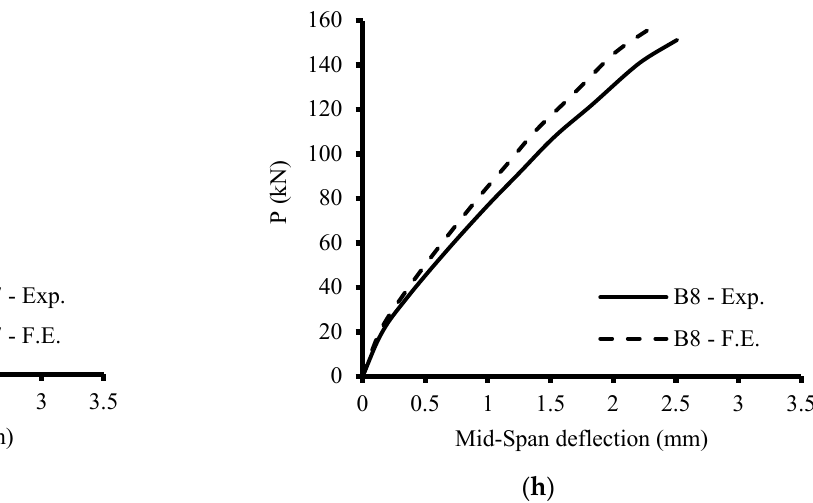
Figure 11. Load deflection curves of the tested specimens (numerical and experimental results). ( a ) Specimen B1; ( b ) Specimen B2; ( c ) Specimen B3; ( d ) Specimen B4; ( e ) Specimen B5; ( f ) Specimen B6; ( g ) Specimen B7; ( h ) Specimen B8.